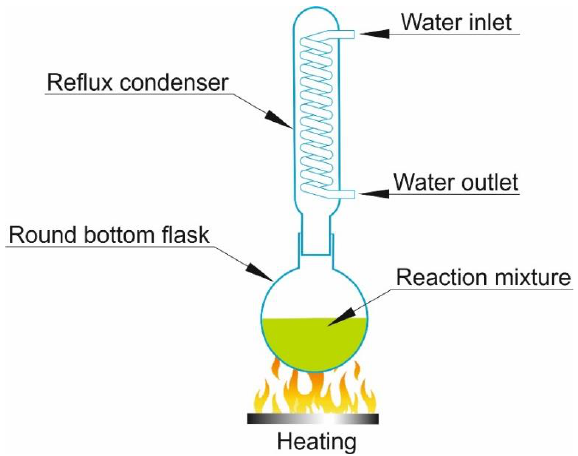
Figure 10. Scheme of the apparatus for carrying out the syntheses connected with the transformations of geraniol.